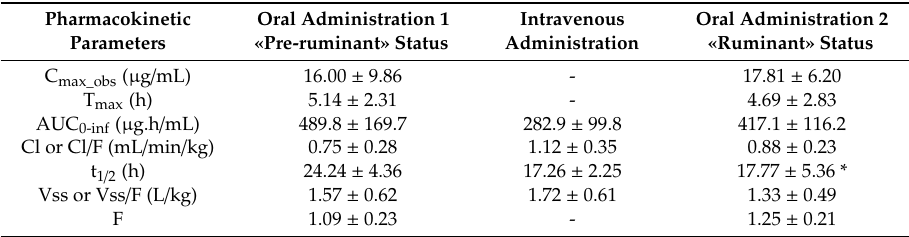
Table 1. Pharmacokinetic parameters of SDM (mean ± SD) after single administrations of a SDM-TMP combination orally (Trisulmix ® Liquid, 24.7 mg / kg SDM + 5.3 mg / kg TMP) or intravenously (Trisulmix ®